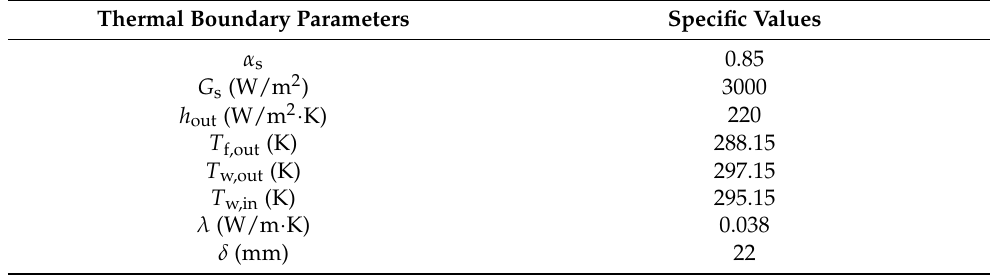
Figure 3. Schematic of the heat transfer model for the indoor thermal environment. ( a ) Initial thermal boundary conditions. ( b ) Complete heat transfer process. Table 2. Parameter settings of indoor and outdoor air temperatures and glass